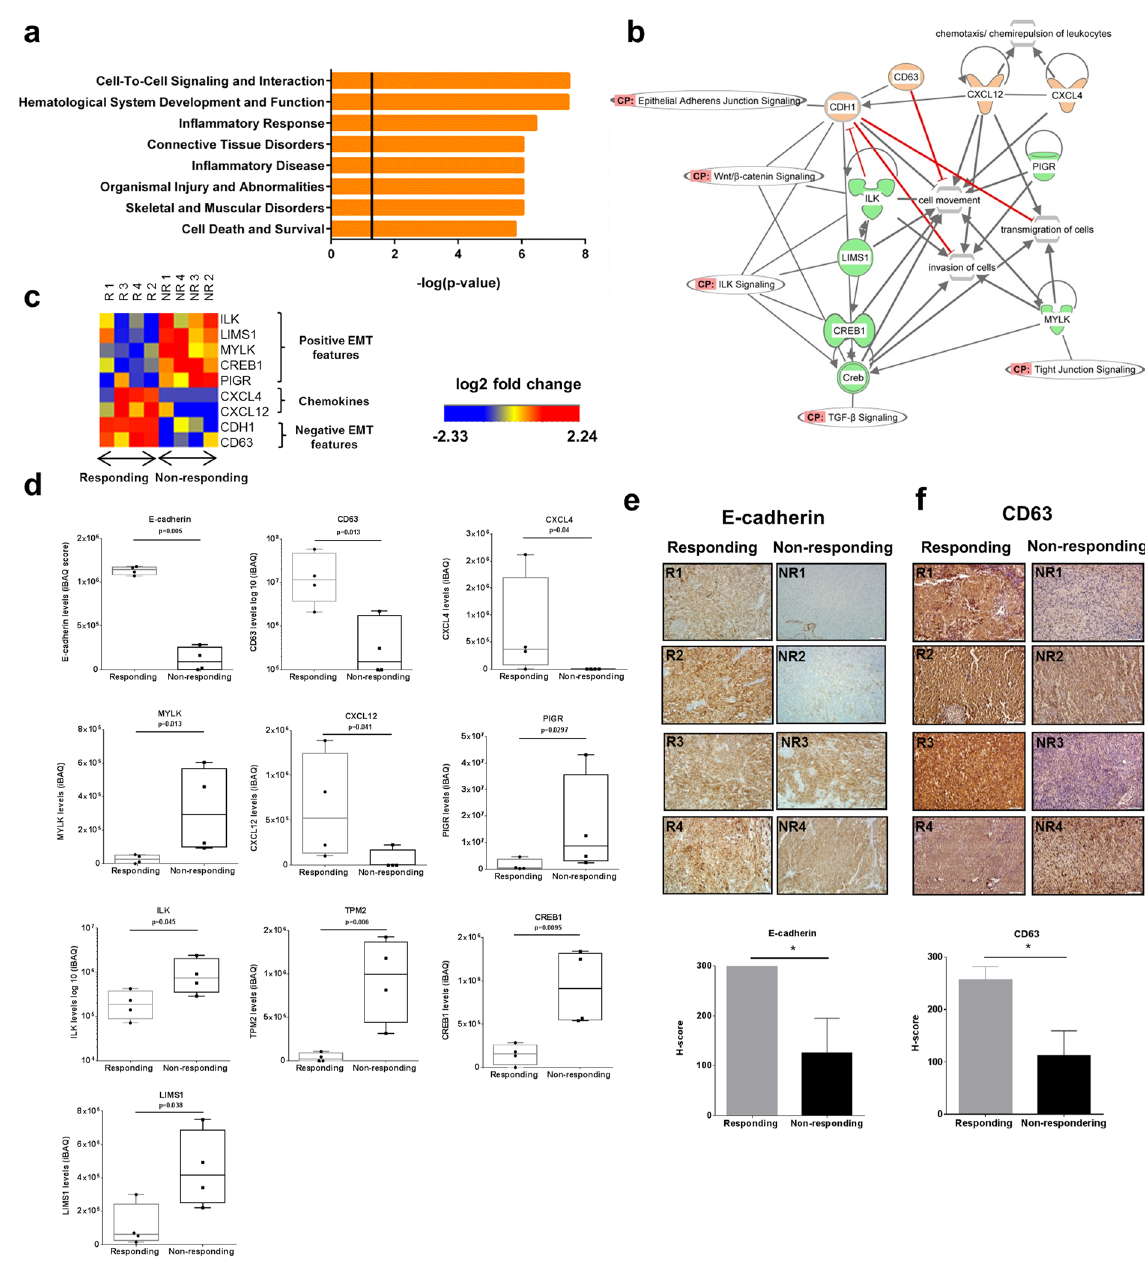
Figure 3. Non-responding tumors show features of mesenchymal transition. ( a ) Ingenuity pathway analysis protein abundance values revealed enriched pathways in non-responding tumors. ( b ) Network map generated by IPA of top pathways, depicting a subset of proteins involved in mesenchymal transtion. Red proteins indicated down-regulation in non-responding tumors, while green indicates up-regulation in non-responding tumors, compared to protein levels in responding tumors. Canonical Pathway tags (CP) show solid lines to proteins which represent biological interactions of select proteins contributing to mesenchymal transition. ( c ) Levels of proteins implicated in mesenchymal transtionand chemokines (by gene name) differentially expressed between the responding versus non-responding pre-treatment tumors. Proteomic iBAQ scores for mesenchymal transition proteins and chemokines. ( d ) Immunohistochemical staining for E-cadherin and CD63 confirmed reduced expression in non-responding tumors. Each image is shown at 20x magnification. Compiled H-score of IHC slides is shown below the histologic images. N = 4 for responding and non- responding tumors. E-cadherin loss is a central event in mesenchymal transtion, while CD63 has been shown to be a negative driver of mesenchymal transition in melanoma ( * p <